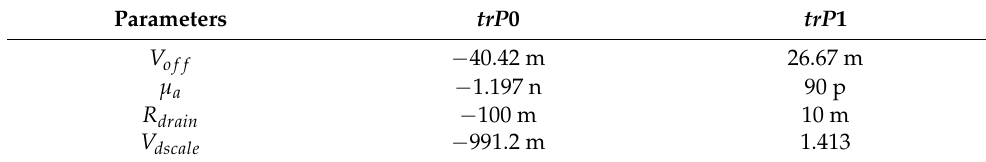
Figure 5 shows the pulsed I DS − V DS measured data and modeled data under different quiescent bias voltages using the trap model proposed in this paper. In this figure, the lines represent the modeled data while the symbols refer to the measured data. As shown in Figure 5, there is an excellent match between the model data and measured data under different quiescent bias voltages, which demonstrates that the proposed trap model can accurately characterize the trapping effects caused by threading dislocations on drain current of GaN HEMTs.